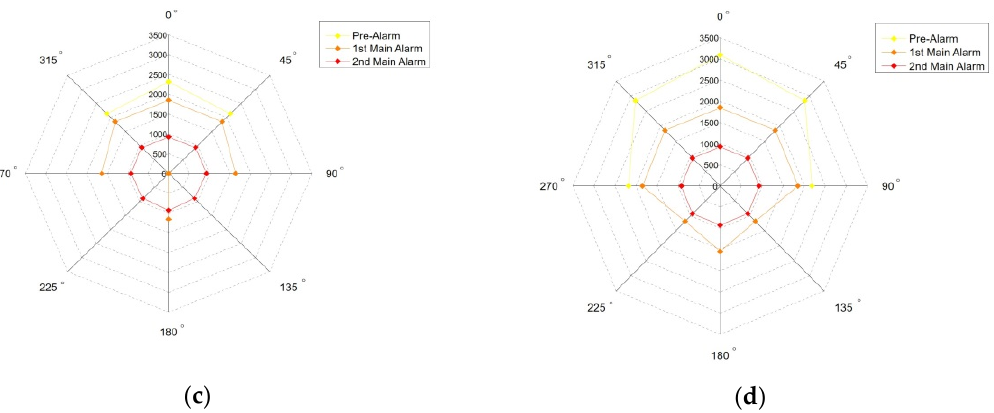
Figure 8. Distance between two vessels at which the alarms are generated for approach speeds of ( a ) 5 knots, ( b ) 10 knots, ( c ) 15 knots, and ( d ) 20 knots.